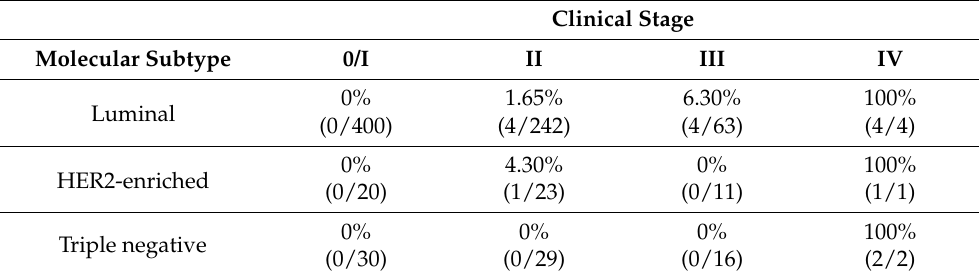
Table 5. The proportion of initial metastasis based on clinical stage and molecular subtype.